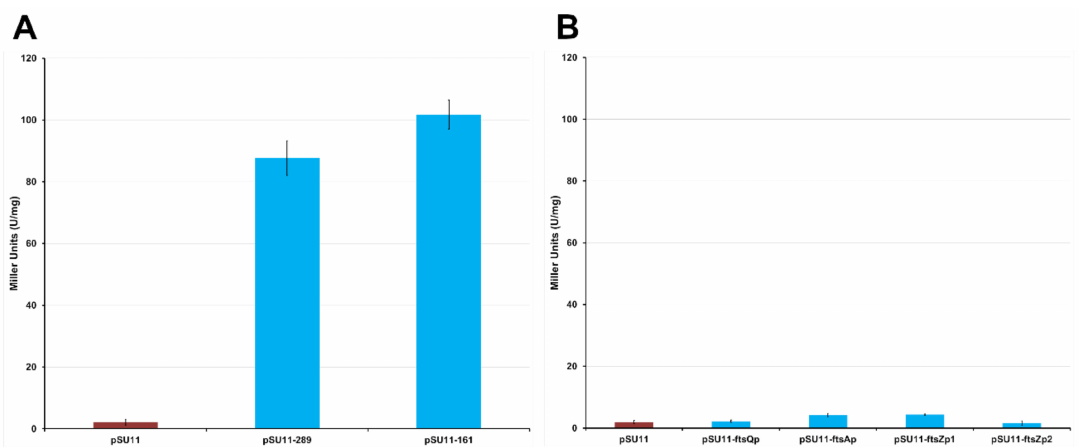
Figure 3. Comparison of the promoter activities of the tested fragments expressed in Miller units. ( A ) Both fragments, 289 bp (pSU11-289) and 161 bp (pSU11-161), amplified from the intergenic region upstream of mraZ , have a strong promoter activity, containing the promoter of the first 15 genes of the dcw operon P mra Bc. ( B ) The four fragments covering the ddl - ftsA region of the dcw cluster show a promoter activity comparable to the negative control (empty pSU11 vector, red bars), demonstrating the absence of additional promoters. Results are expressed as mean of 3 experiments and the error bars represent the standard